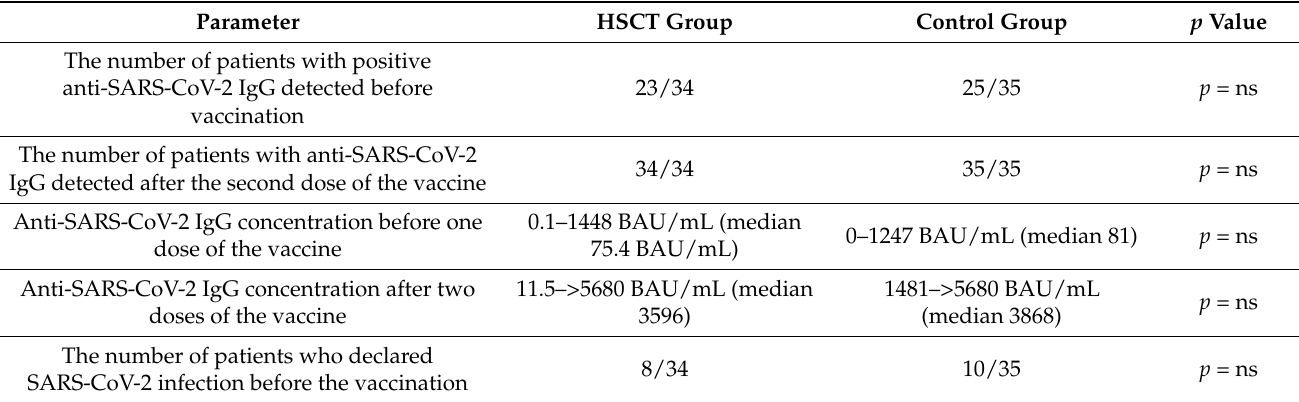
Table 2. Anti-SARS-CoV-2 status before the vaccination and the immunologic answer to the vaccination.